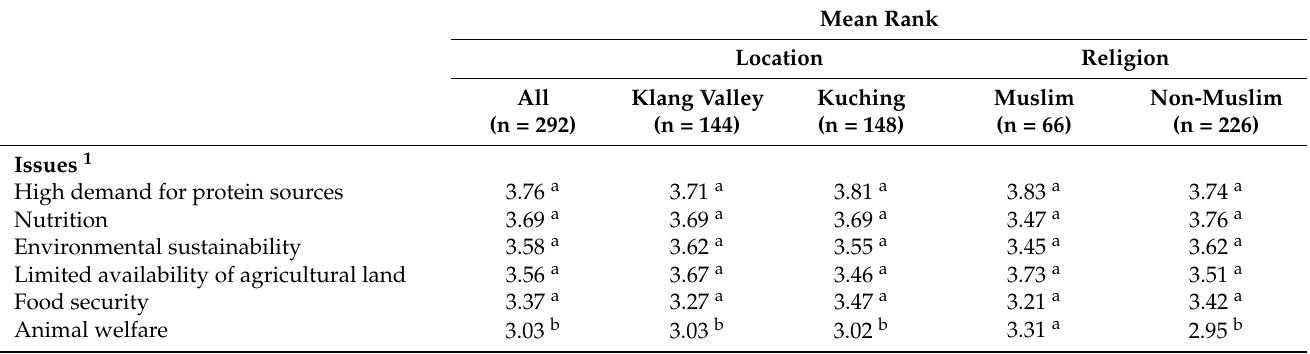
Table 5. Issues that could be addressed through entomophagy according to study location and